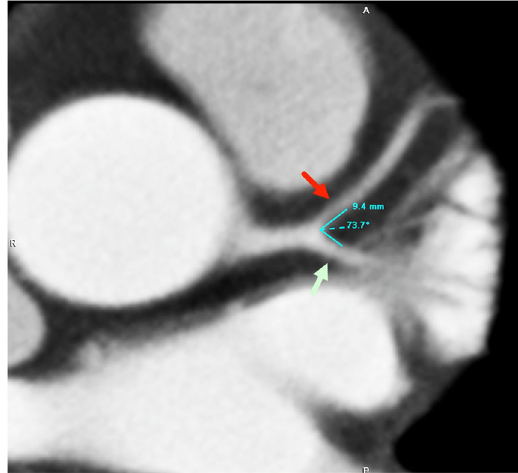
Figure 1. A 53-year-old male with normal findings of the LAD (red arrow) and LCX (light green arrow). The calcium score was zero. The angle between the LAD and the LCX measures